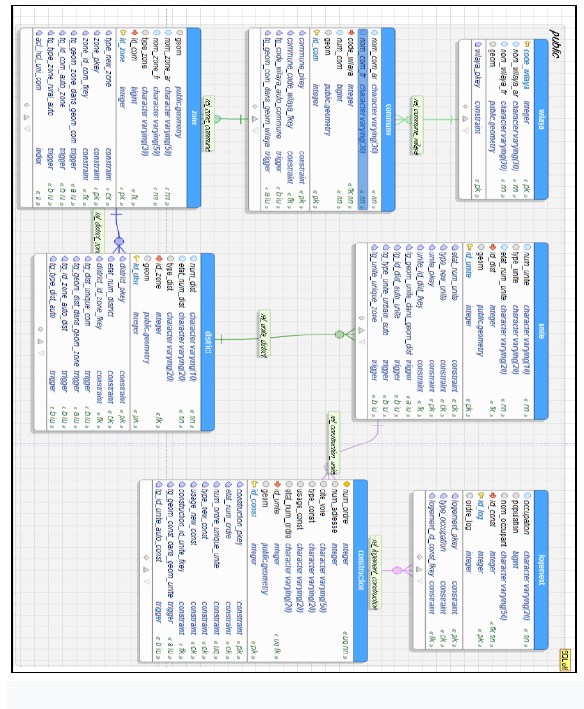
Figure 4 . conceptual data model after adding constraints.